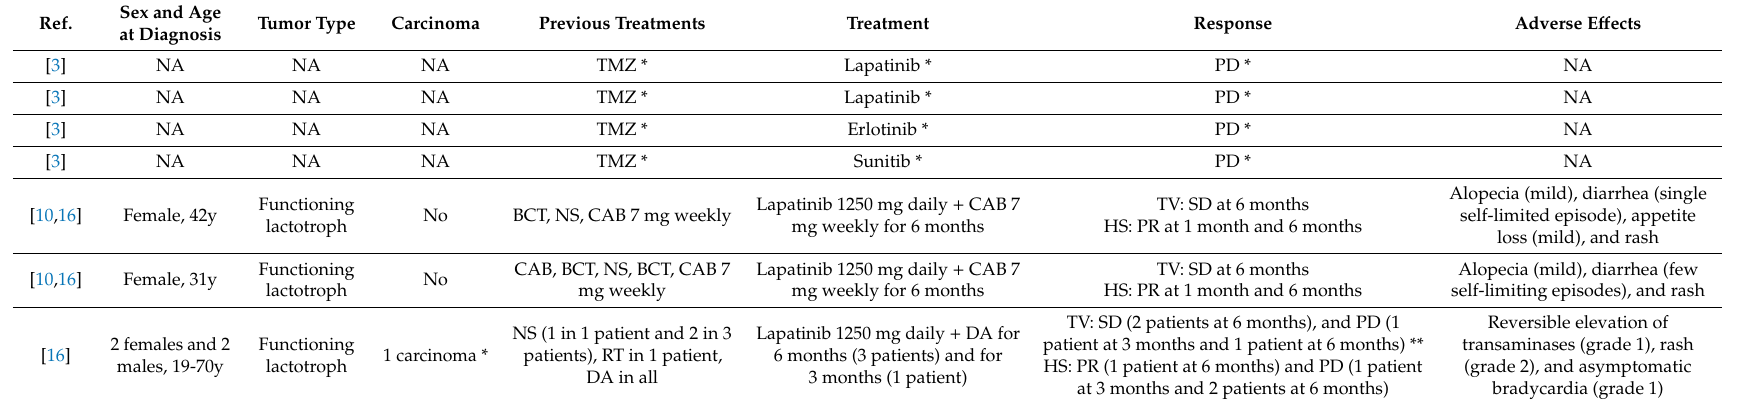
Table 1. Cases of aggressive pituitary neuroendocrine tumors and pituitary carcinomas treated with tyrosine kinase (TK) inhibitors.